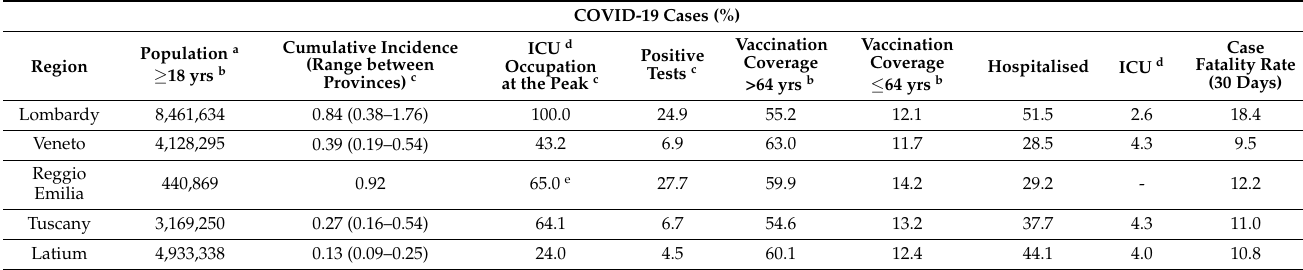
Table 1. Demographic characteristics of the areas included in the study and main epidemiological parameters of the first wave of the COVID-19 pandemic, 21 February to 17 May